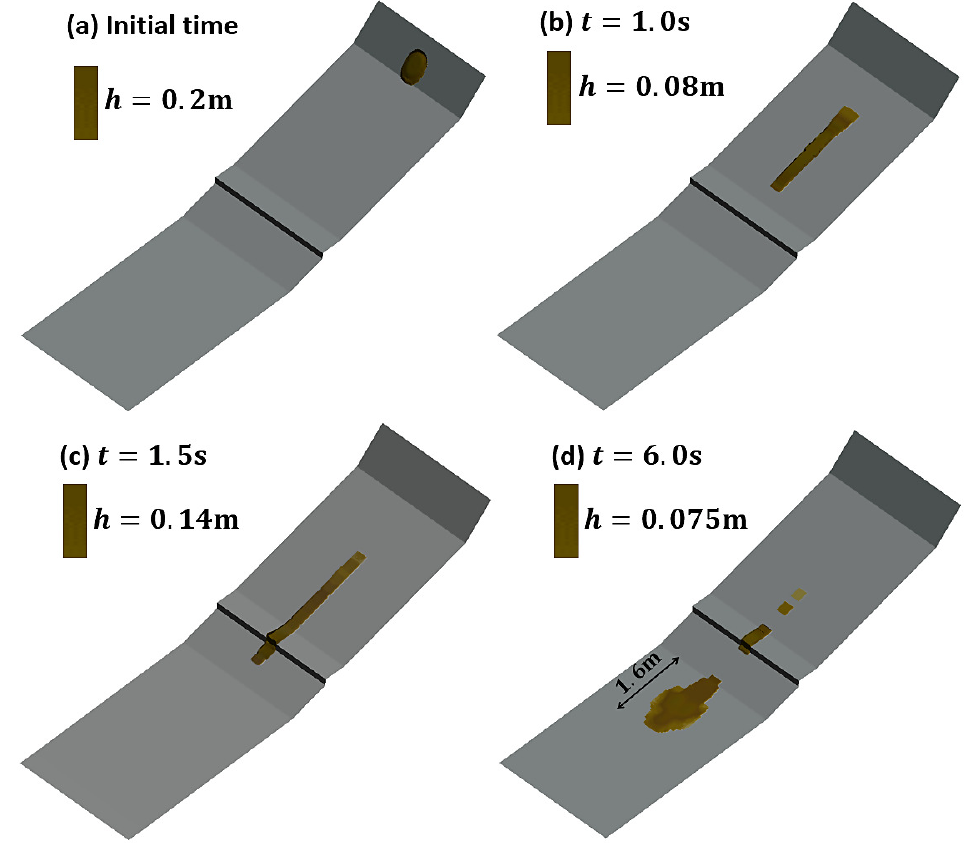
Figure 6. Three-dimensional depth-integrated modeling of a flume test equipped by a bottom drainage screen at times (a) 0 s, ( b ) 1.0 s, ( c ) 1.5 s and ( d ) 6.0